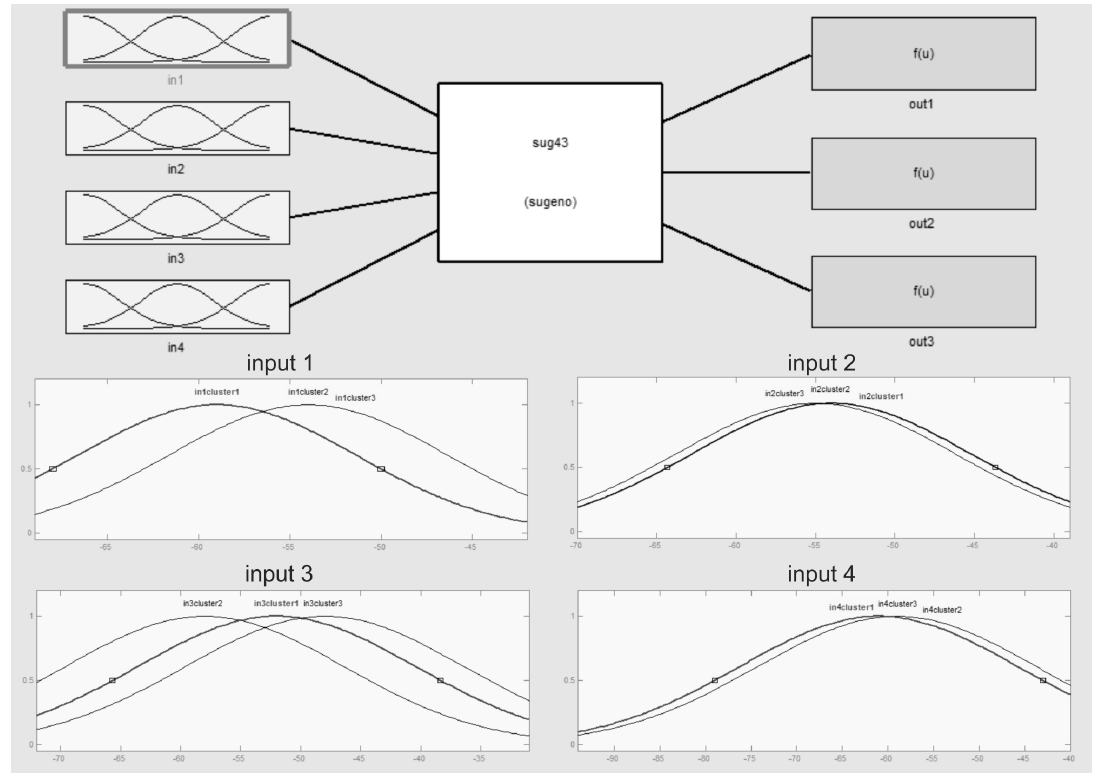
Figure 12. TSK FIS structure with four inputs, three rules and three